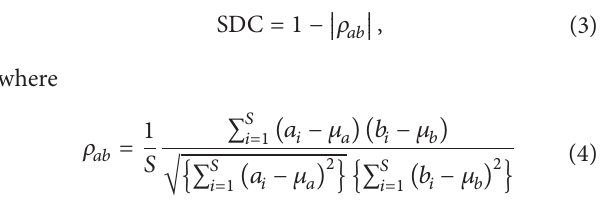
work a value of 1.05 was selected for 𝛽 as it is the commonly used value [22–24].